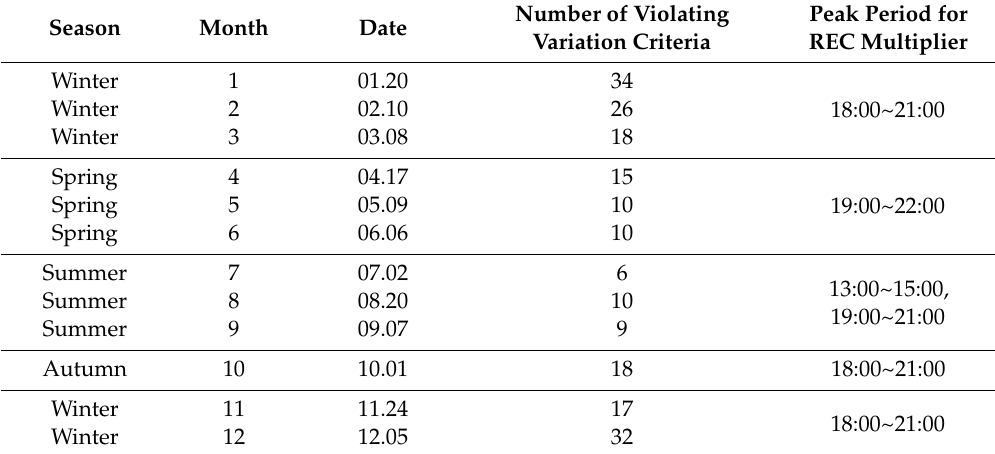
Table 2. The number of violations of the variation criteria and peak period for the renewable energy certificate (REC) multiplier.